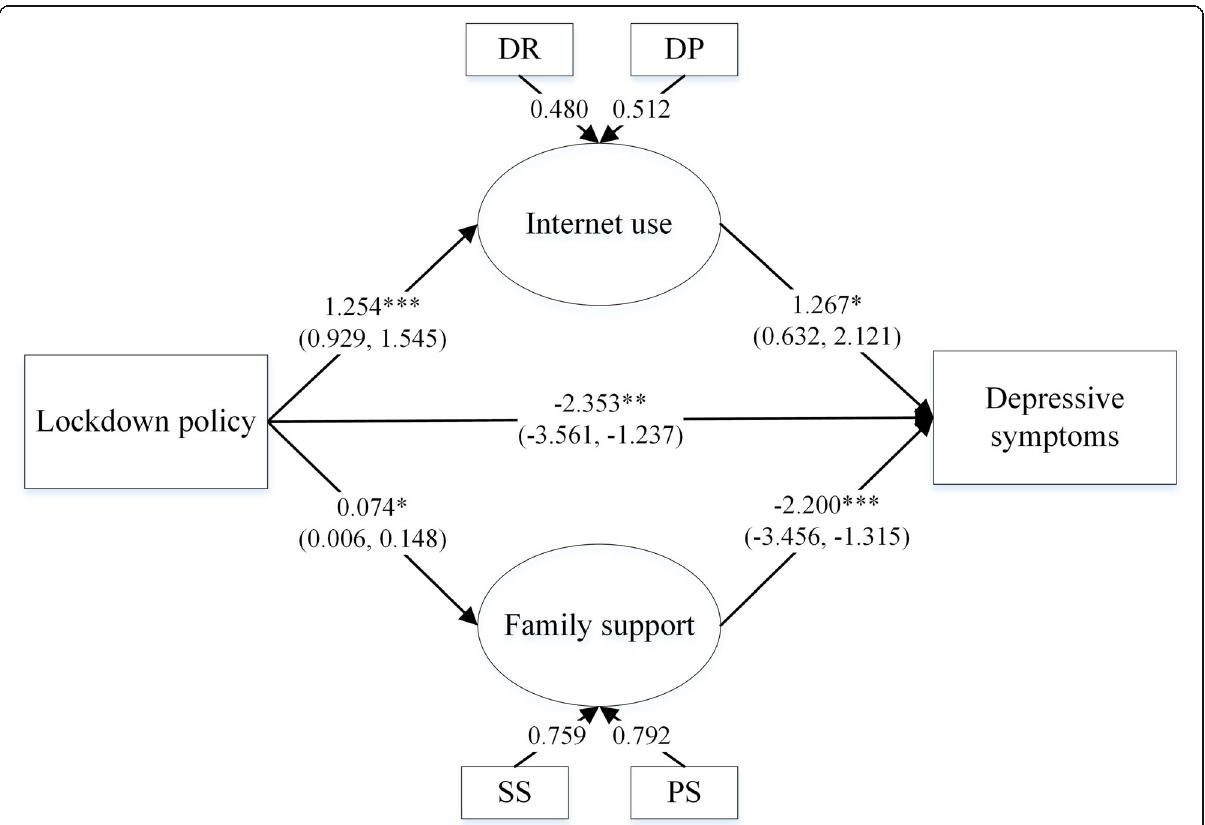
Fig. 2 Results of the hypothesized model. N.B. DR: Duration of the Internet use, DP: Diversity of Internet use purposes, SS: Spousal support, PS: Parental support. All models controlled for age, education, living arrangement, planned pregnancy, alcohol consumption, annual household income and financial loss due to COVID-19 pandemic. *: p < 0.05, **: p < 0.01, ***: p <